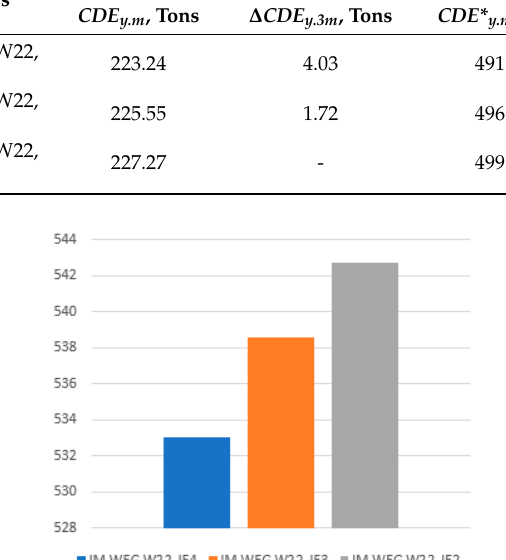
Figure 5. Annual cost savings S y.3m (€).